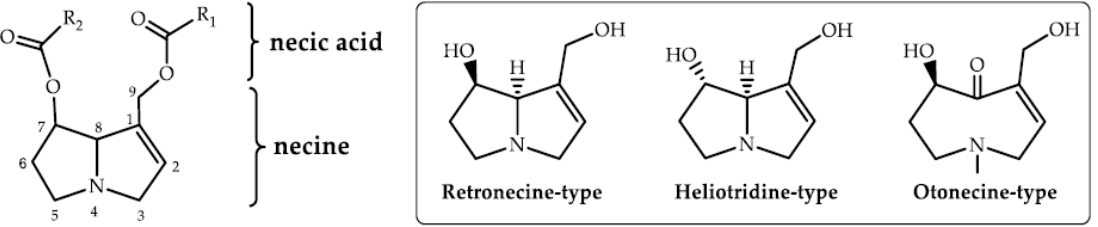
Figure 1. The chemical structures of toxic pyrrolizidine alkaloids. ( A ) is the basic skeleton and ( B ) is three main types of PAs.